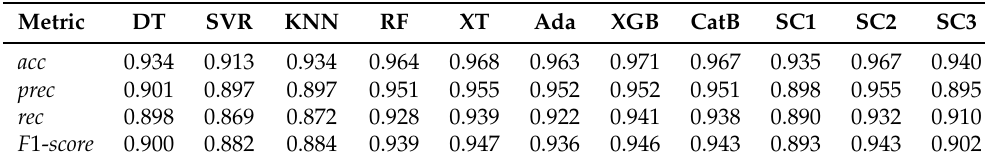
Table 3. Accuracy metrics for the implemented